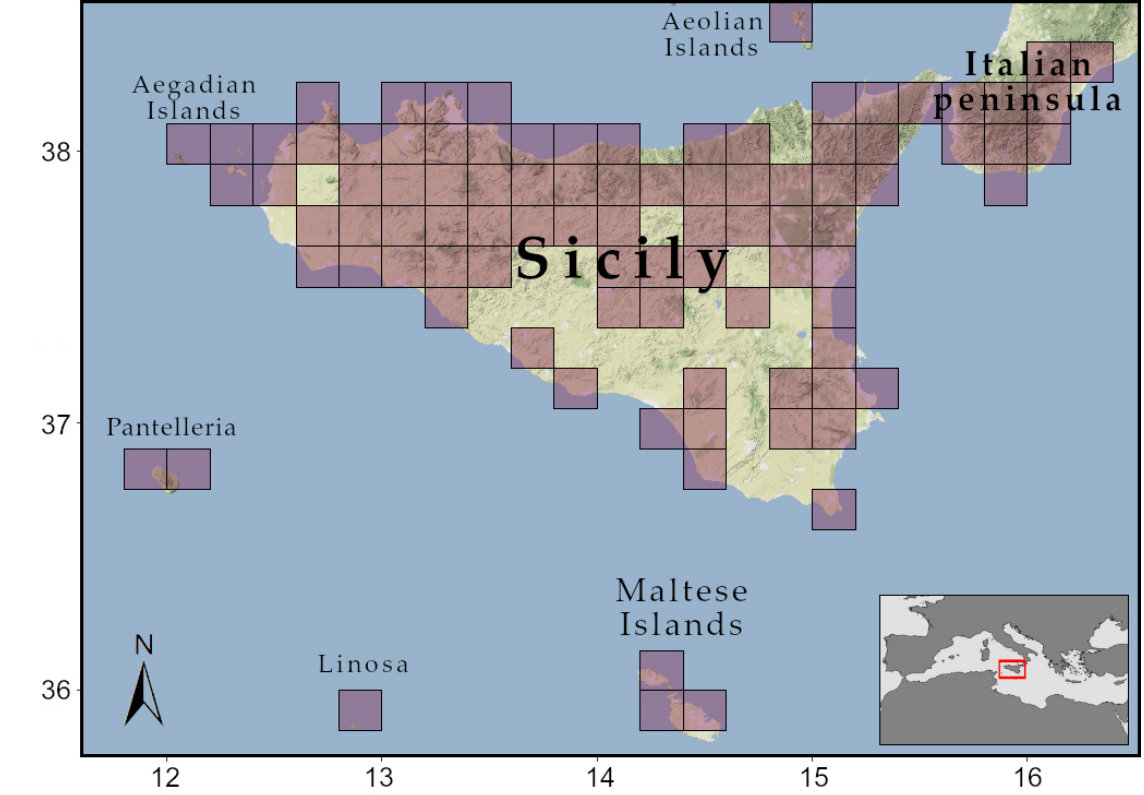
Fig. 1. Sampling efforts across Sicily and neighboring regions according to the geographic origin of the samples in the authors’